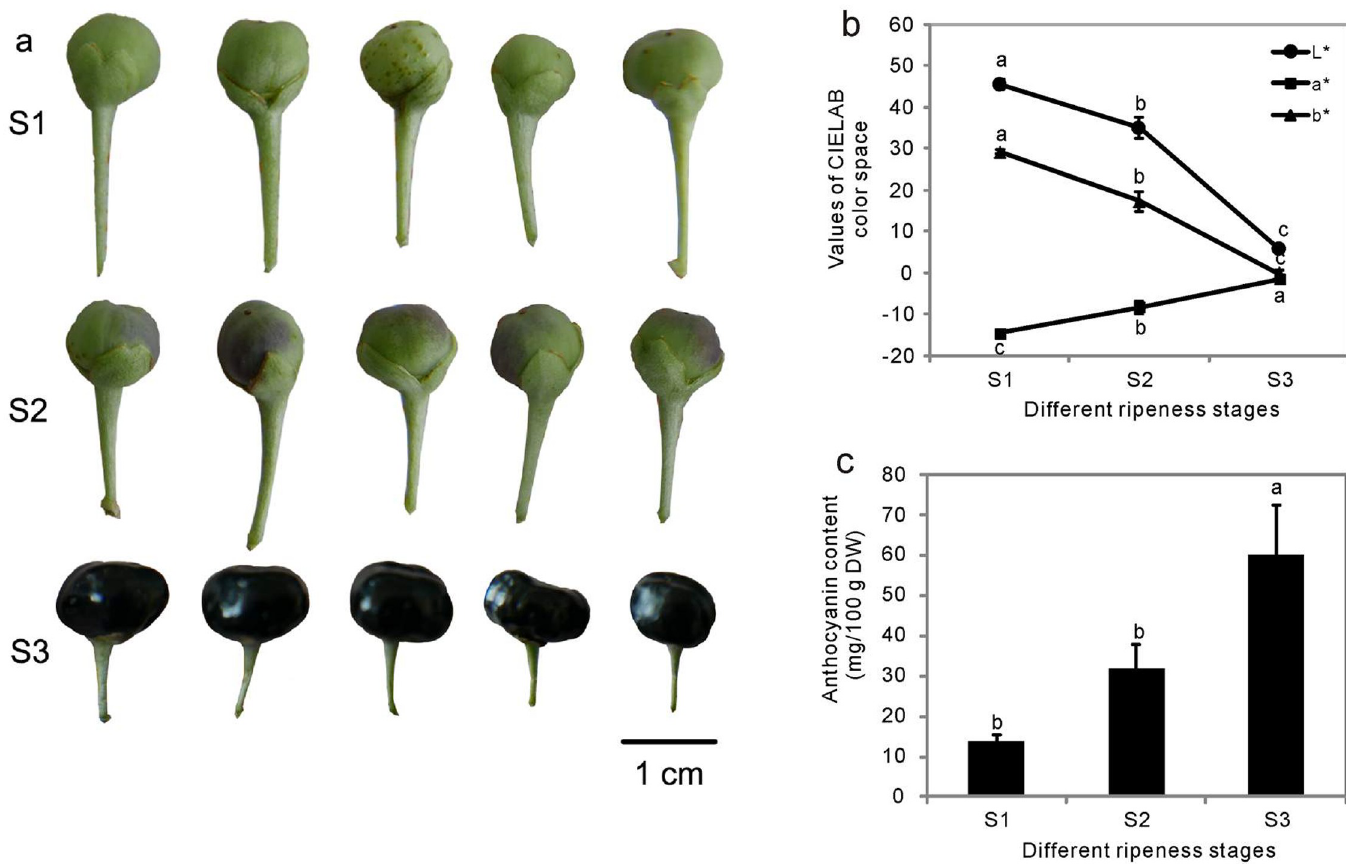
Fig 1. Images of L . ruthenicum fruits and anthocyanin contents in the fruits. (a) Fruits of L . ruthenicum at different ripeness stages selected for RNA-Seq. Representative photographs of fruits at the green ripeness stage (S1), skin color change (S2), and complete ripeness stage (S3). (b) Values of L . ruthenicum fruit color based on CIELab color space. L � , lightness, a � , green–red axis, b � , blue–yellow axis. (c) Anthocyanin contents in the fruits of L . ruthenicum at different ripeness stages. Values are the means ± standard error (SE) ( n = 3). Different letters among the columns indicate significant differences ( P � 0.05).